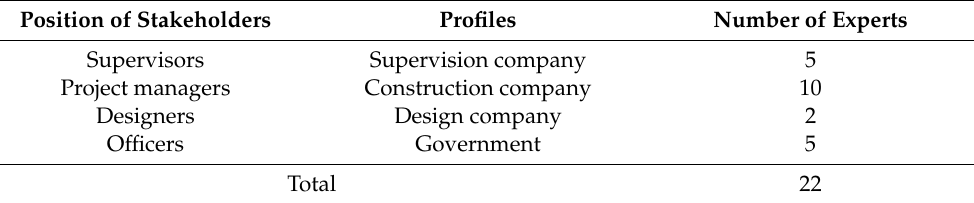
Table 2. The position and number of experts in the interview.